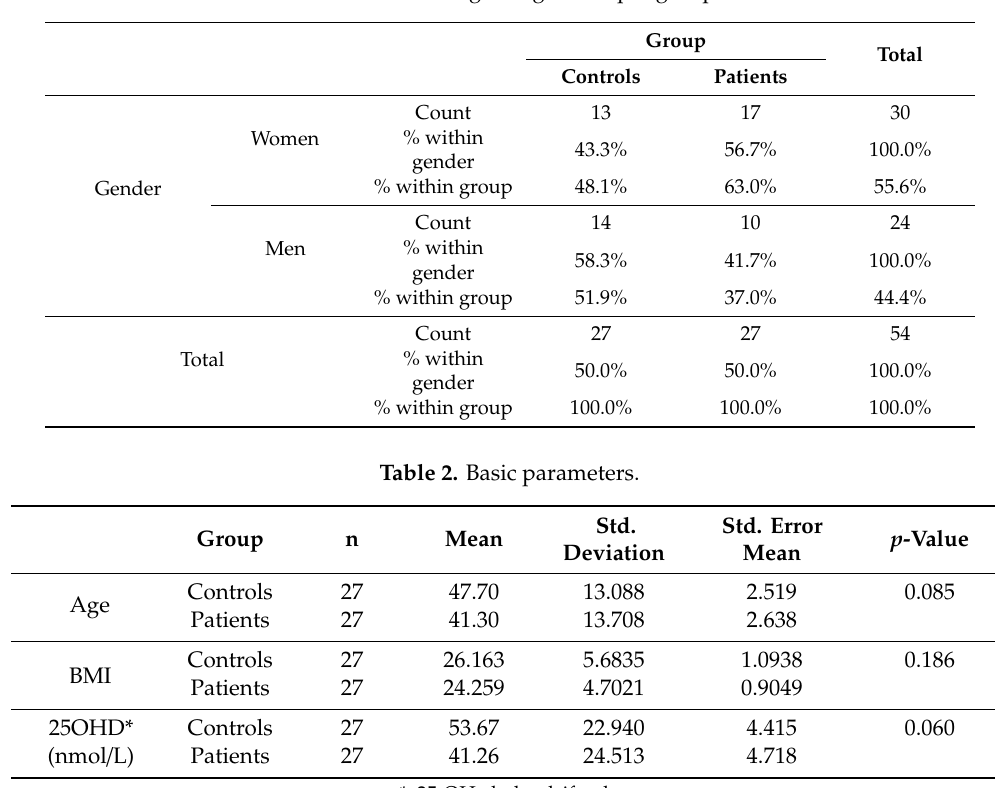
Table 1. Percentages of genders per group.